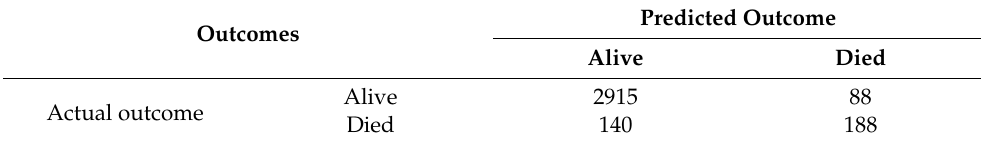
Table 3. Confusion matrix of J48